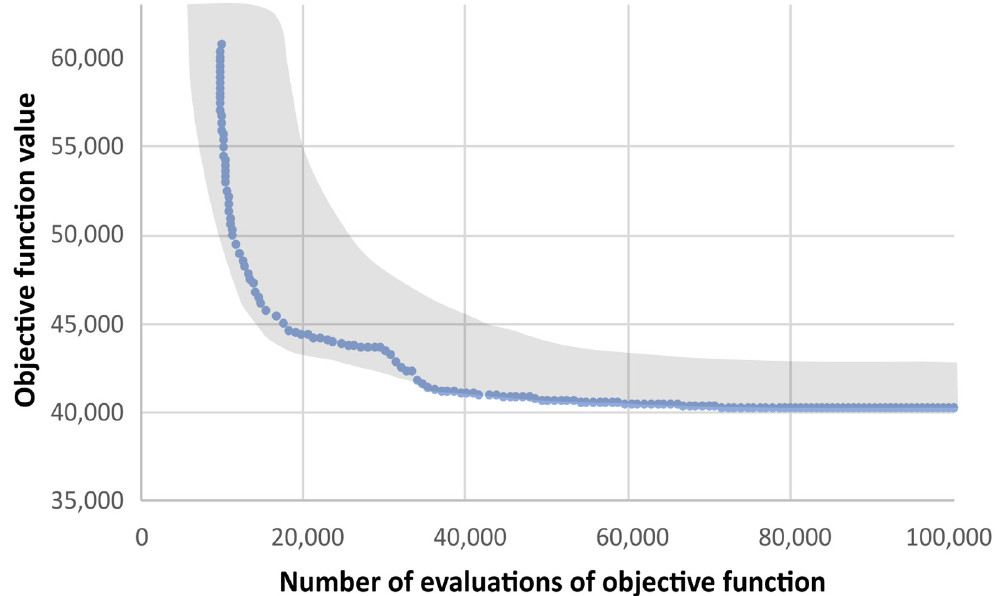
Figure 6. Optimization process evolution.